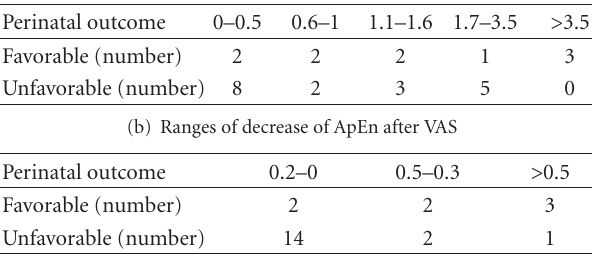
Table 5: Modifications of STV (a) and ApEn (b) after VAS in high- risk pregnancies between 28th and 36th week of gestation.